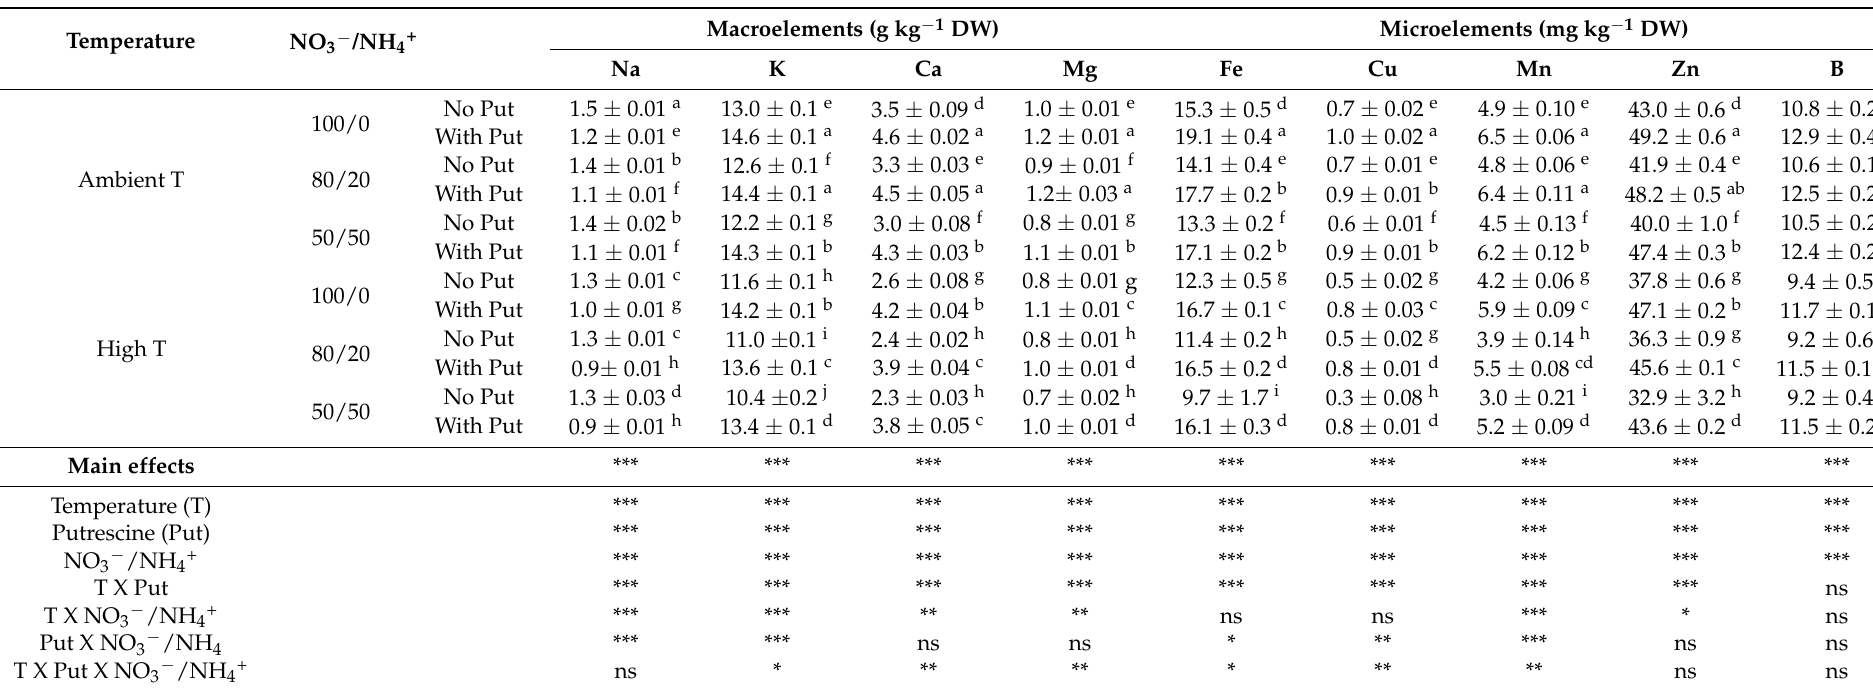
Table 5. Effect of foliar application of putrescine (2.5 mM) on cations in younger leaves of the cauliflower cv. Moonshine at different ration of NO 3 − /NH 4+ and temperatures. Temperature